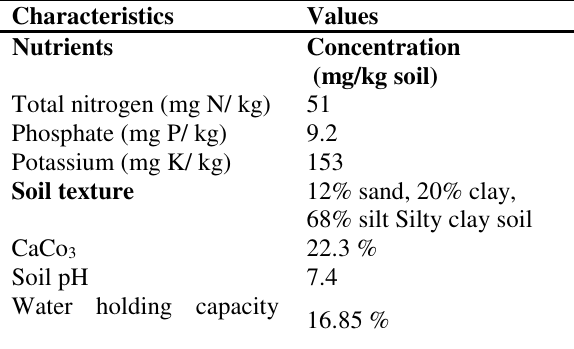
Physical and chemical properties of the used soil